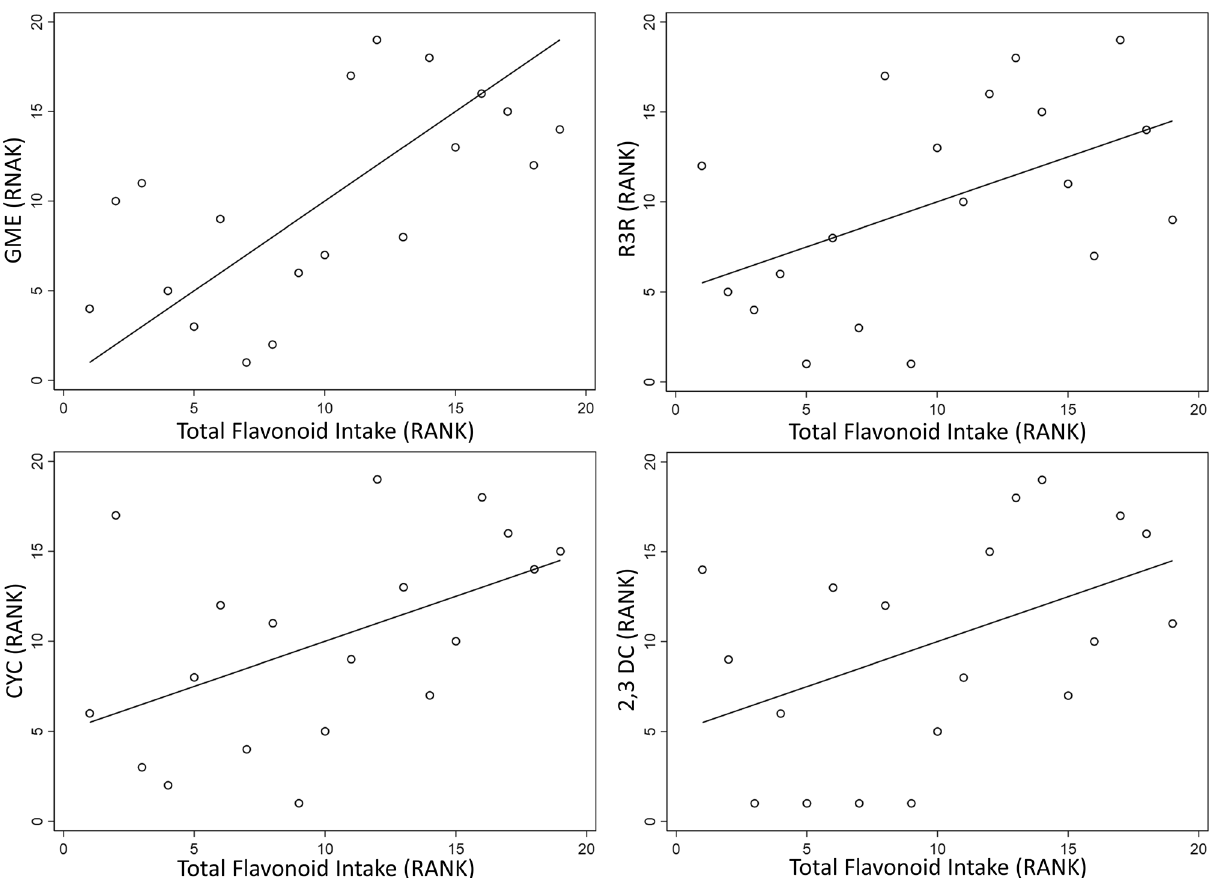
Figure 2. Scatter plot of predicted intake of flavonoids based upon FFQ compared measures of serum biomarkers.